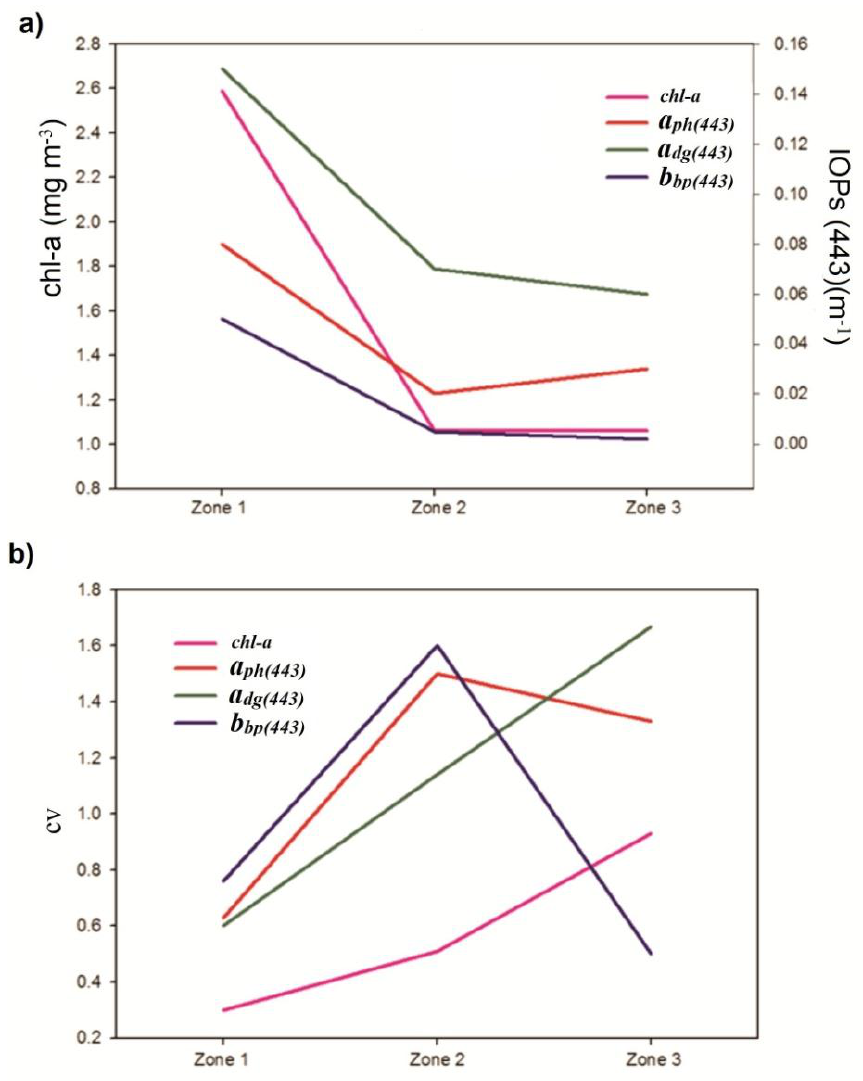
Figure 4. Climatology of the IOPs in the study area. ( a ) Mean values; ( b ) coefficient of variation. The bio-optical parameters for zones 2 (inner-shelf) and 3 (mid-shelf) are very similar in terms of mean values (Figure 4). Some differences are, however, noticeable in the coefficients of variability, especially for b bp (443), which is two times higher in zone 2 than in zone 3, and for chl -a , which is much more variable in zone 3 than in zone 2 . The average seasonal behavior of these parameters presents differences depending on the area (Figure 5). In zones 1 and 2 a ph (443), b bp (443), and a dg (443) showed the highest values in autumn and winter, and the lowest values in summer, with a noticeable difference on the mean values between the coastal zone and the inner- and mid-shelf (Figure 5). During spring, Zone 3 showed the highest values of chl- a and a ph (443), possibly related to a higher phytoplankton biomass, but also a dg (443), which may indicate higher concentrations of CDOM and non-pigmented particles. For all these parameters, minimum values were observed in late summer. In this area, mean values of b bp (443) does not present significant seasonal